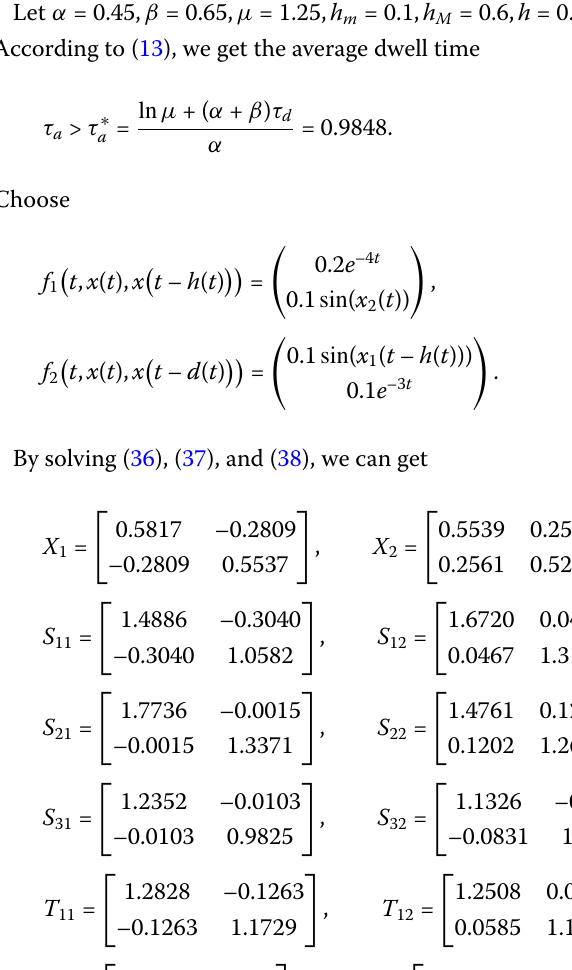
Table 1 Calculated upper delay bound h M α 0.55 0.6 0.65 0.7 0.75 h M ( β = 0.7) 0.677 0.733 0.827